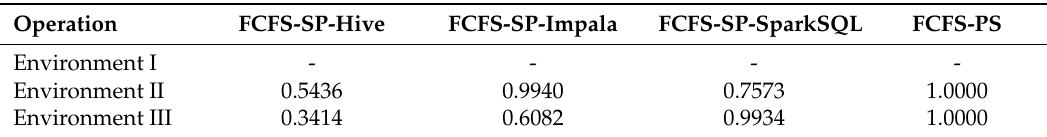
Table 10. Normalized performance index for Case 1.